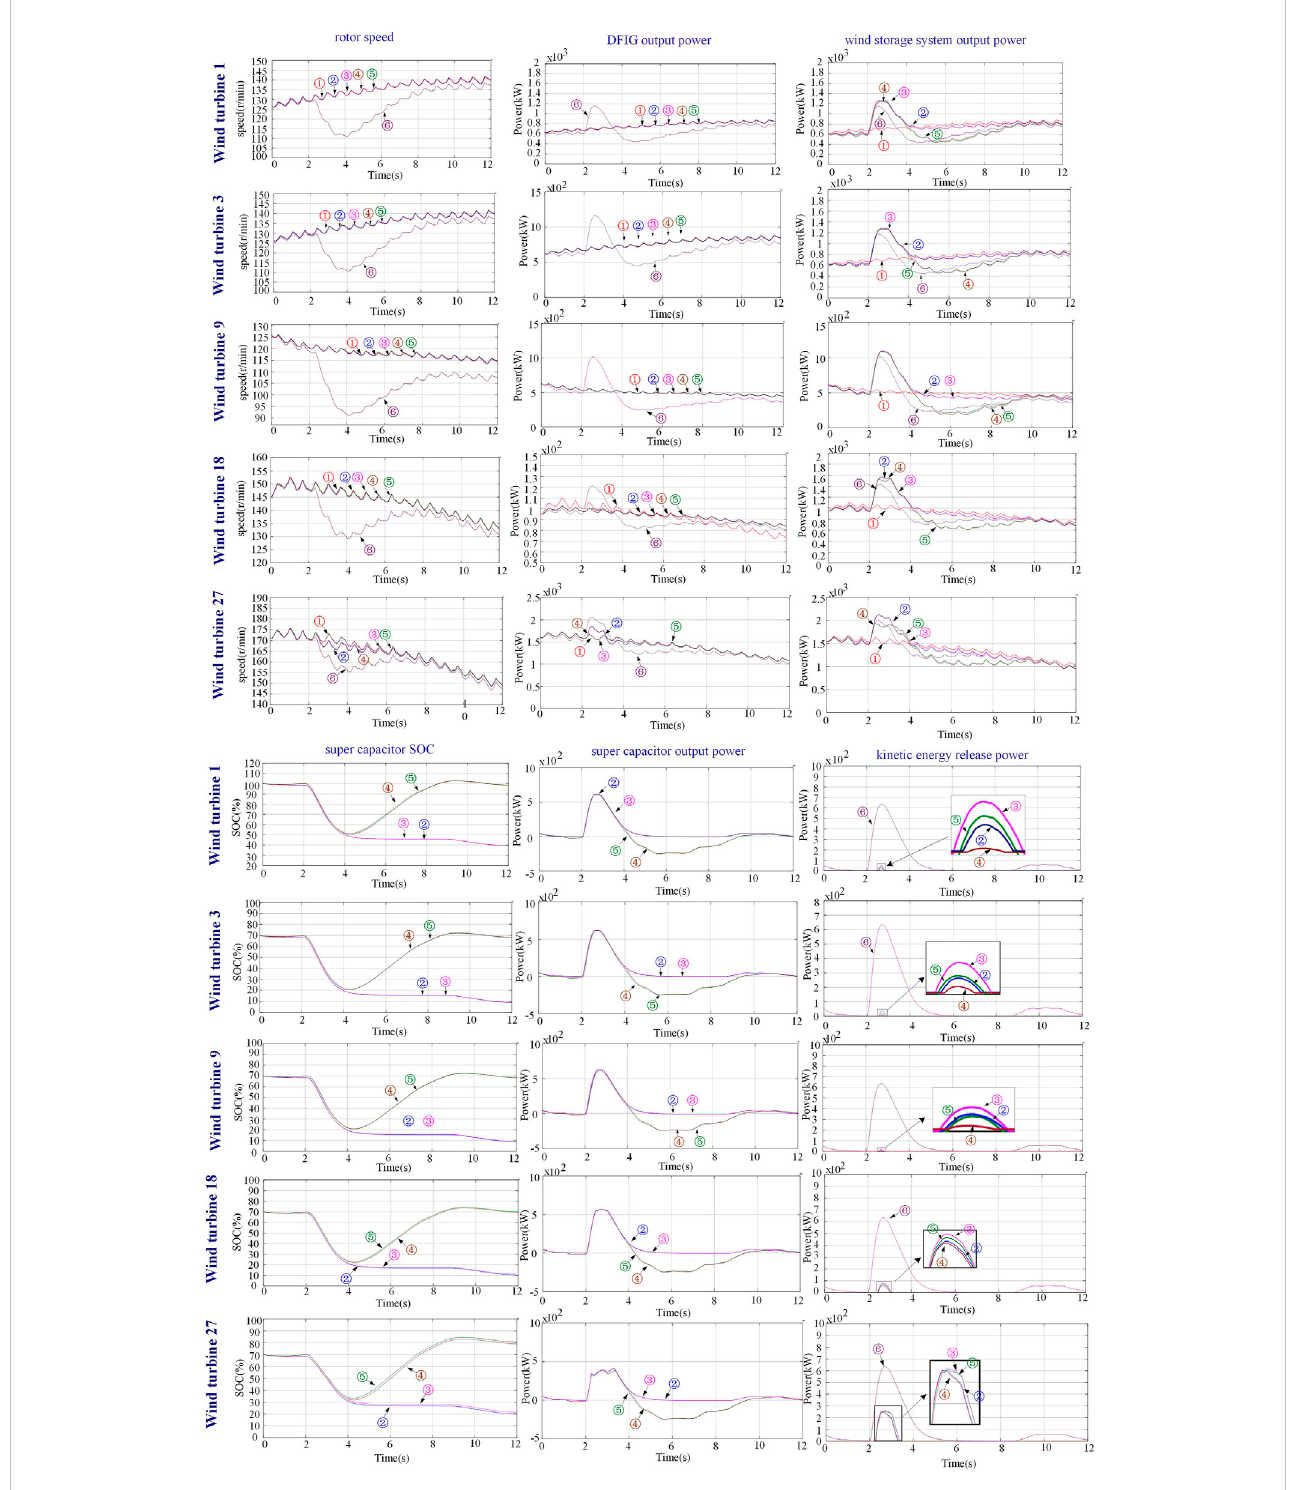
FIGURE 12 State operation curves of some SCESS-DFIGs under different working